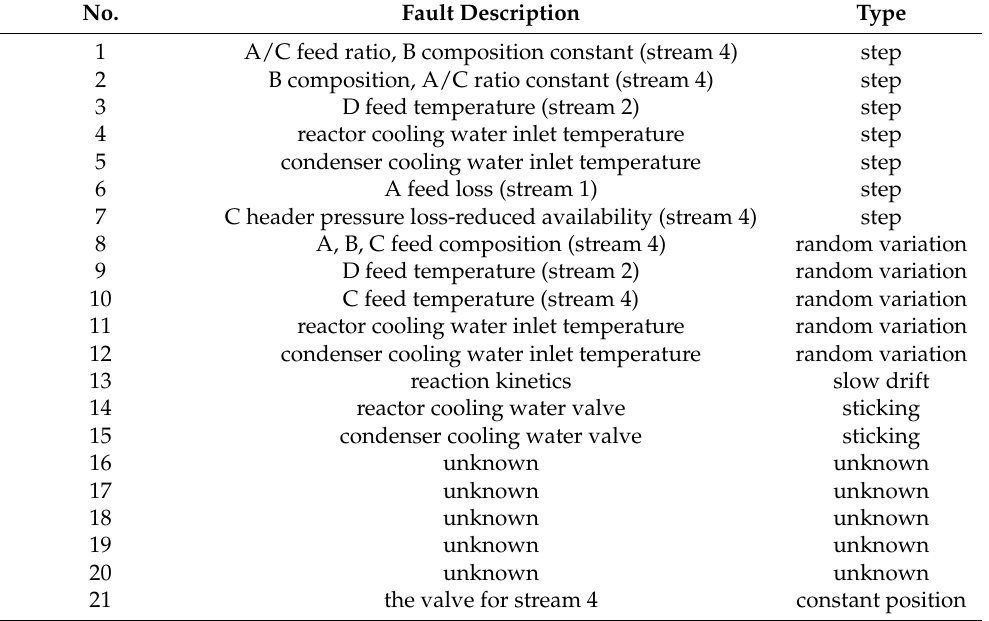
Table 1. Programmed faults in the TE process.